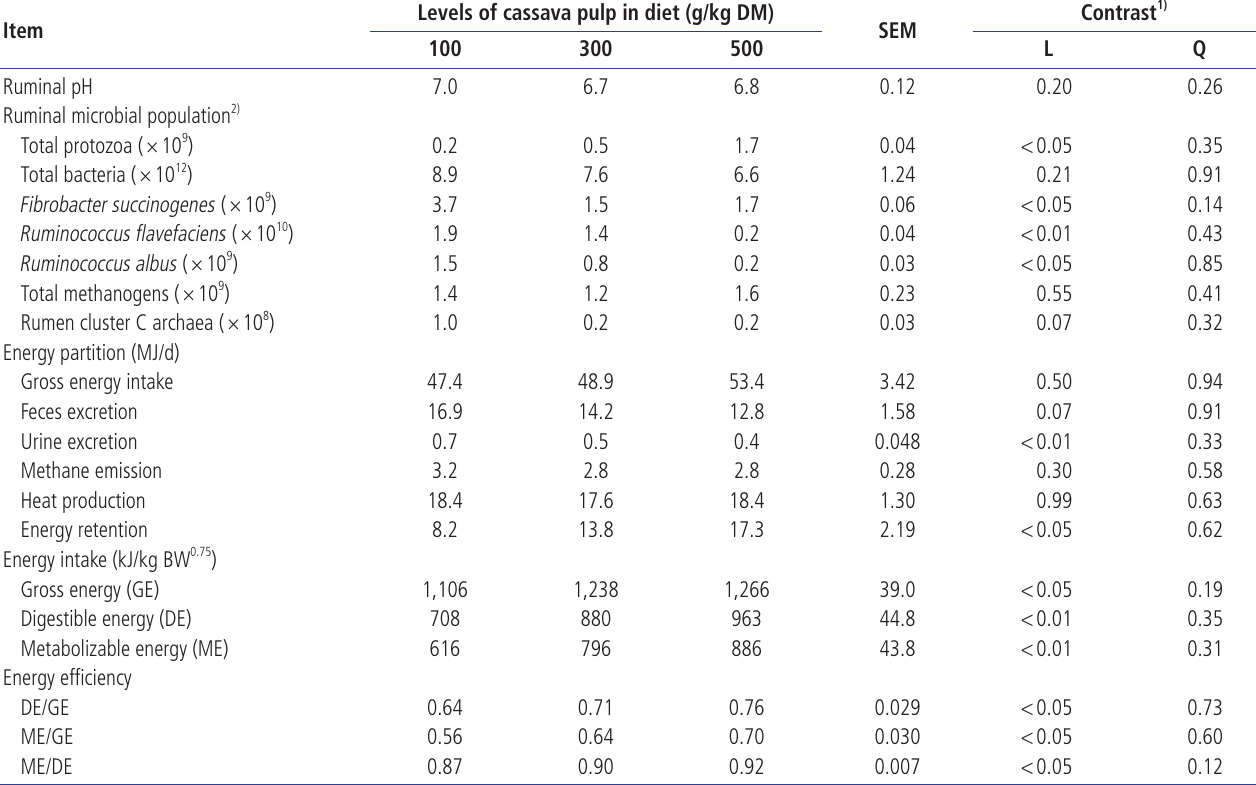
Table 3. Effects of replacing rice straw with cassava pulp in the fermented total mixed ration on rumen pH; microbial populations; and energy partitioning, intake and efficiency by Thai native beef cattle (n = 18) Item